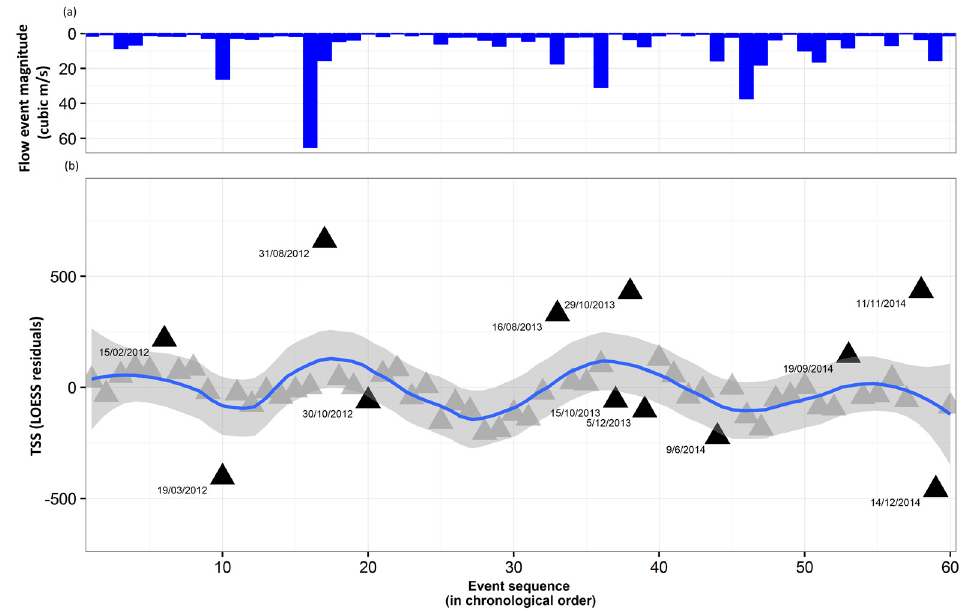
Figure 9. ( a ) Flow event magnitudes; ( b ) TSS residuals event (n = 60) analysis from the period 2012–2014 for the Hoteo catchment outlet in order of occurrence showing periods of higher amounts of sediment than expected followed by lower amounts of sediment than expected. The sine-like wave (blue LOESS line with 95% confidence intervals) suggests that after major TSS events (concave), sediment in the landscape is exhausted (convex). Similar patterns were described in Knox’s (1972) [15] seminal paper occurring over thousand years or millennia. Our results show that these processes also take place on yearly or monthly time scales. The date (dd/mm/yyyy) is shown on extreme events.